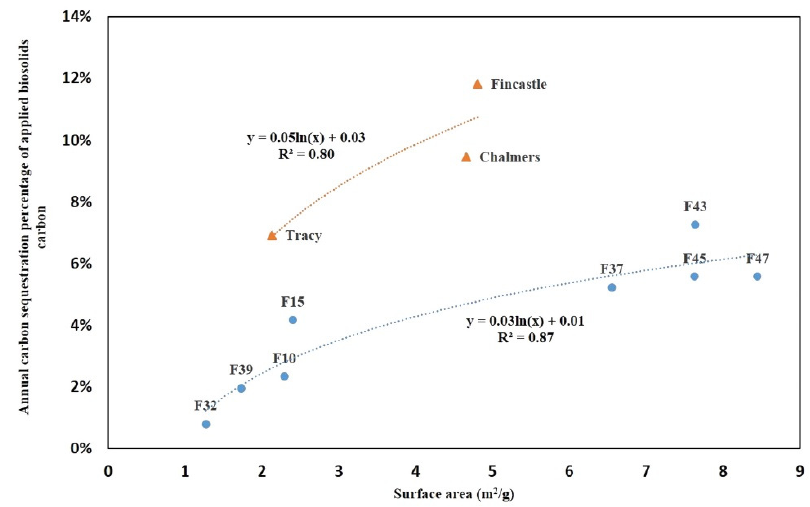
Figure 7. Annual percentages of applied biosolids converted to sequestered carbon as a function of mineral soil surface area for field (10 °C and 10% moisture) and laboratory conditions (21 °C and 20% moisture). Sequestered % is based on first order kinetics and a biomass yield of 40%.